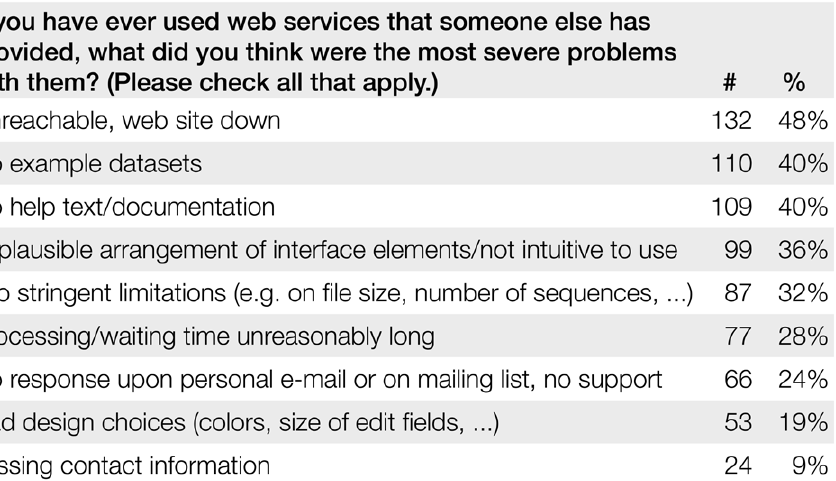
Figure 5. The main issues respondents have with other Web services. In our survey among 274 authors, we asked about problems using other bioinformatics Web services. The order of answers was randomized for each respondent and multiple answers were possible. Ranked in the first place is the users’ main complaint, i.e., that the Web site hosting the service was not functional. We can therefore infer that users are willing to overlook other problems with a service as long as it is in fact